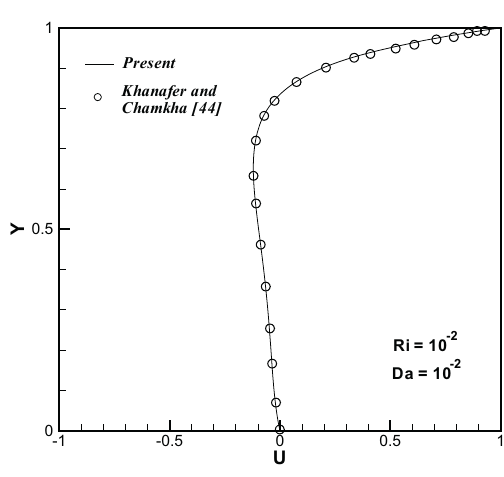
Fig. 3: Comparison of the mid-plane velocity profiles of Khanafer and Chamkha [44].